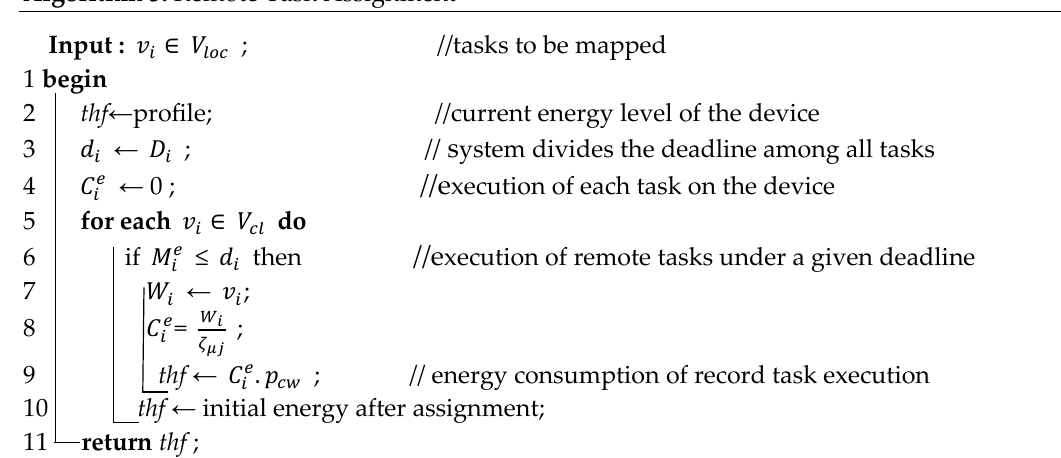
Algorithm 3: Remote Task Assignment